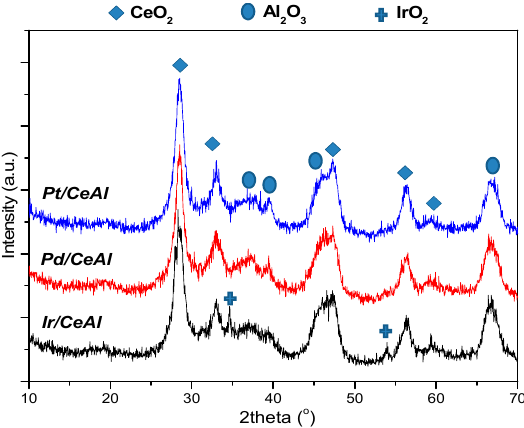
/ CeAl, Pd / CeAl and Ir / CeAl